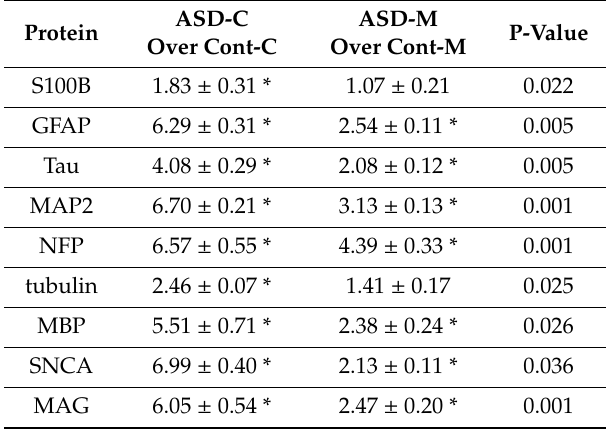
Table 4. Fold Increase of autoantibodies against neural proteins in the serum of children with ASD compared to control children. Similar comparisons were made between mothers of ASD children and mothers of control